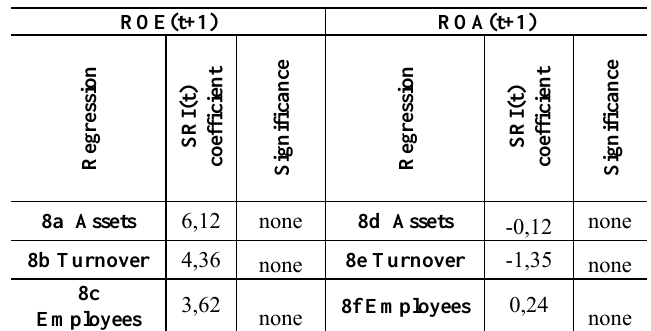
Table 7: Linear regression following Waddock & Graves (1997) – using social performance as a predictor of financial performance